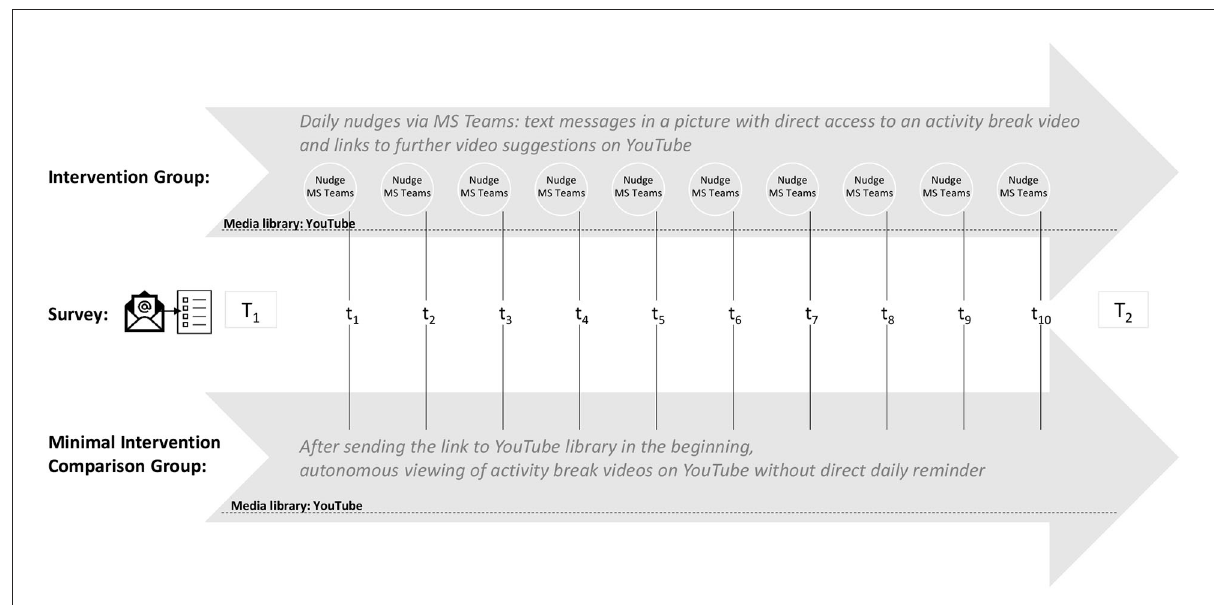
FIGURE1 Design and procedure of the study for both groups: digital nudging intervention group (IG) and minimal intervention control group (MICG).